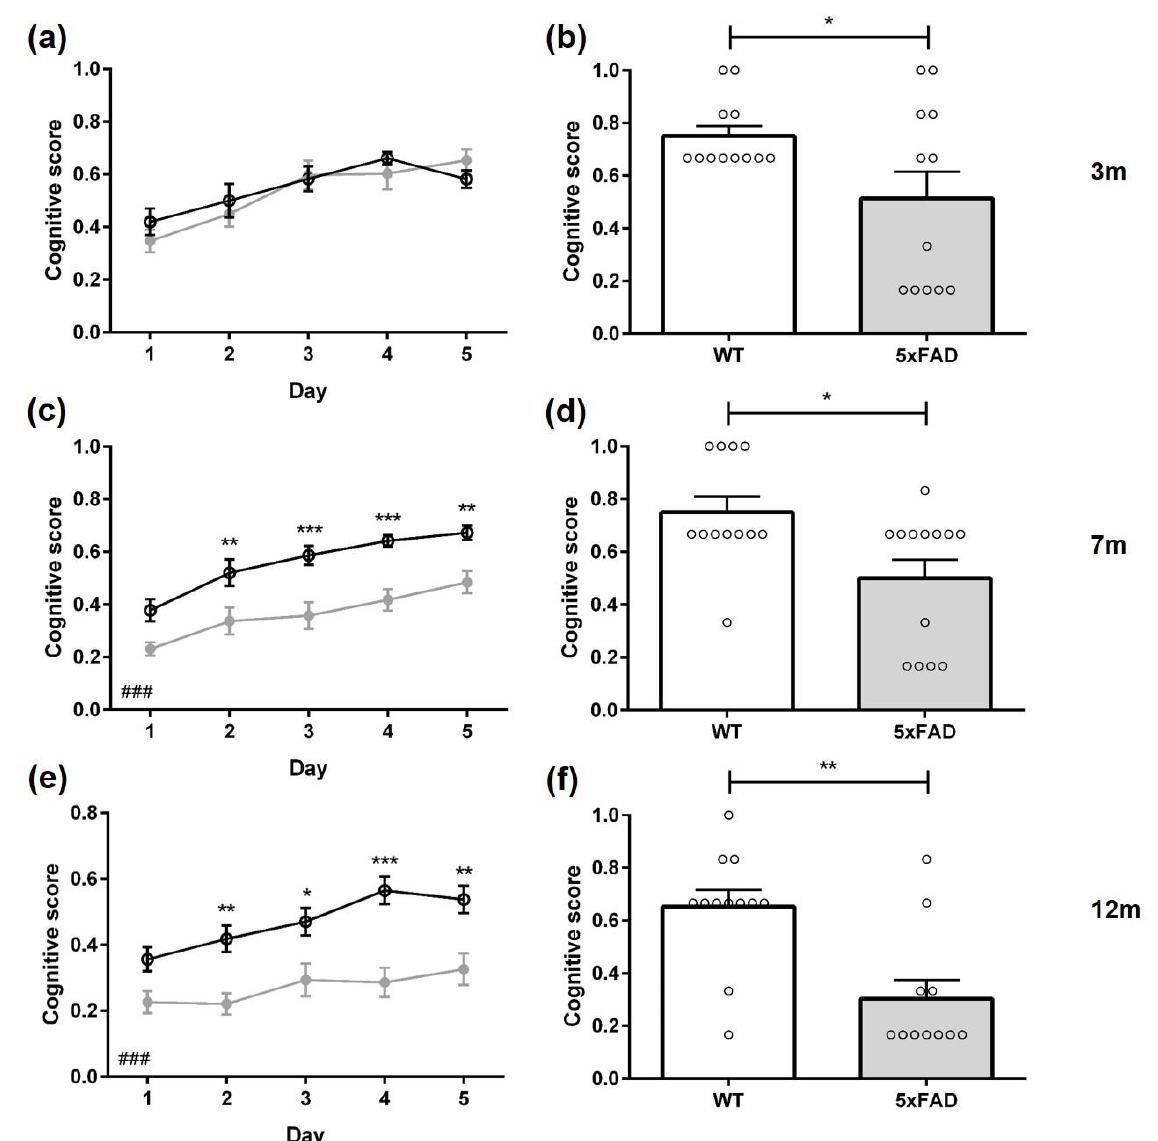
Figure 7. Cognitive scores of female 5xFAD mice. The cognitive scores of 5xFAD decreased age-dependently in the acquisition training ( a , c , e ) and the probe trial ( b , d , f ). Data presented as mean ± S.E.M., n = 10–13. Acquisition training: two-way repeated measures analysis of variance (ANOVA) followed by Bonferroni multiple comparisons. ANOVA: ### p < 0.001; Bonferroni: * p < 0.05, ** p < 0.01, *** p < 0.001. Probe trial: unpaired t -test: * p < 0.05, ** p < 0.01. During the probe trial, 53% of 3-month-old 5xFAD animals used non-spatial search strategies with predominately ‘random search’. In contrast, WT mice relied on different forms of spatial search strategies (Figure 6a: p = 0.0133). In addition, female three-month-old 5xFAD mice showed a lower cognitive score than WT animals (Figure 7b: F(12,11) = 7.002, p = 0.0404). (Table S1, WT 60%, 5xFAD 88%) during the first day of acquisition training. Over